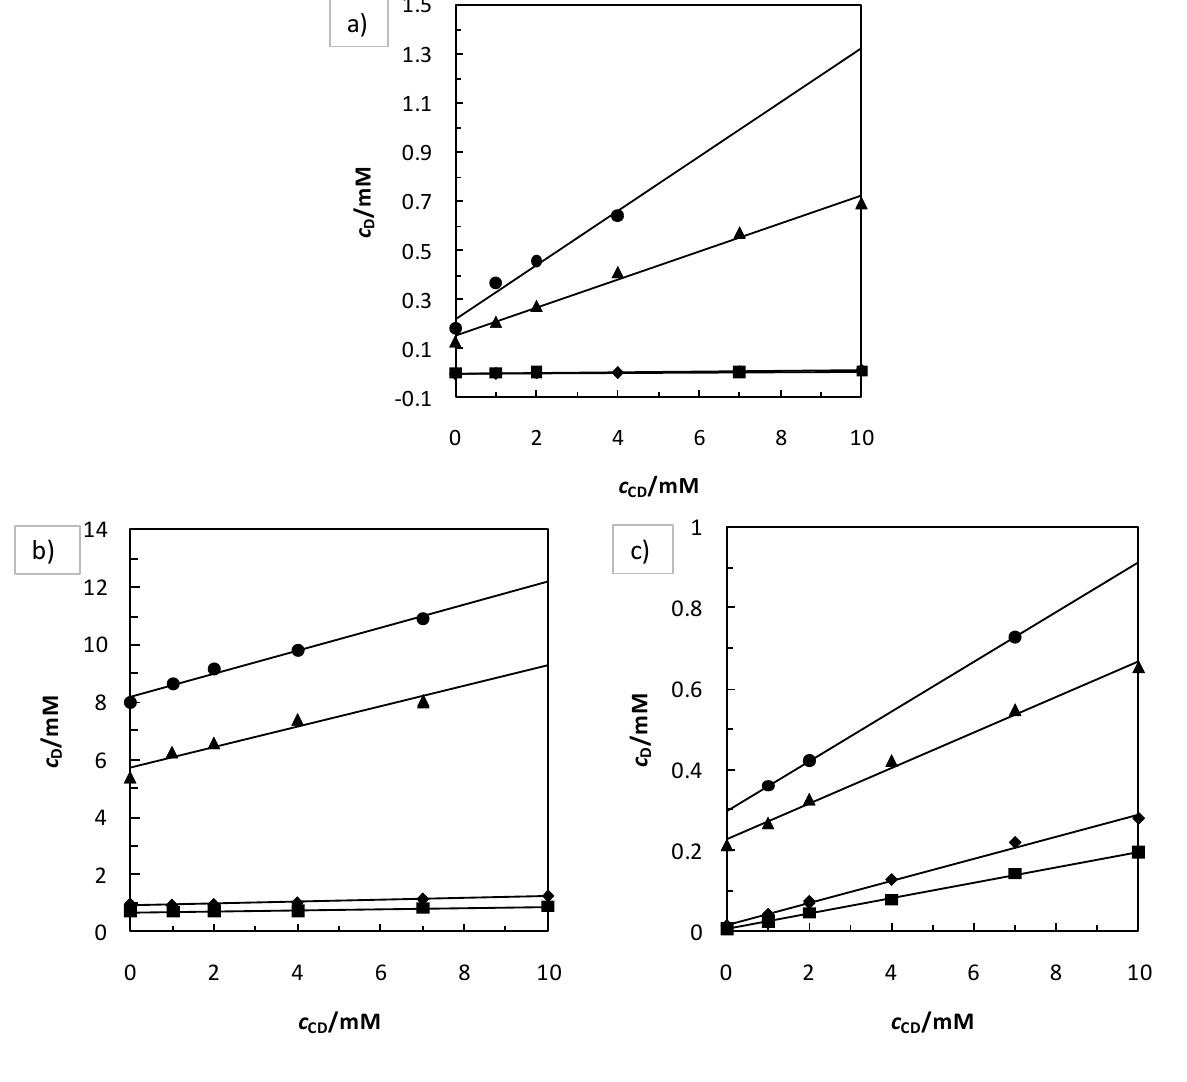
Figure 2. 2HP- β -CD influence on the drug solubility at different temperatures and pHs. Experimental points: (  ) pH = 2 and T = 298.15 K; (  ) pH = 2 and T = 310.15 K; (  ) pH = 7 and T = 298.15 K; (  ) pH = 7 and T = 310.15 K; Lines are drown to show the trends. ( a ) Mefenamic acid dependence; ( b ) Niflumic acid dependence; ( c ) Flufenamic acid